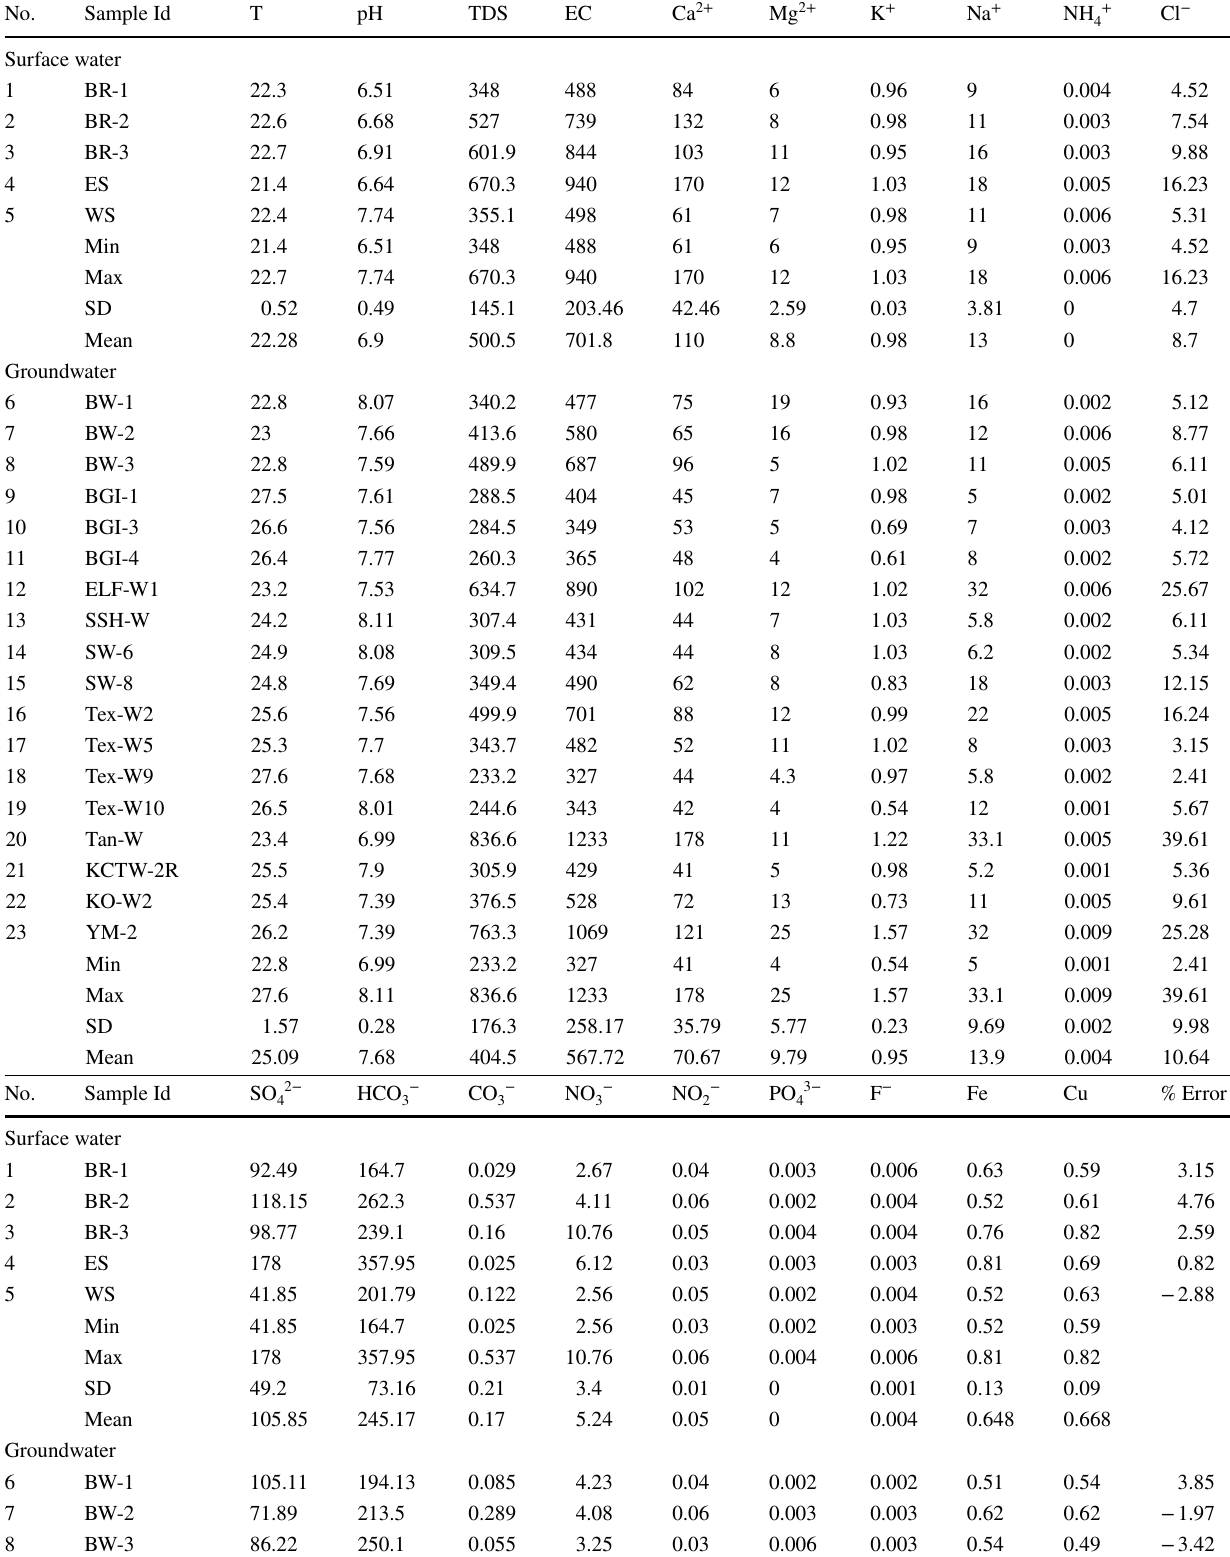
Table 4 Results of chemical analyses of the surface water and groundwater samples of the study area (date of sampling: Nov 2017); explanation: EC (µS/cm), concentrations (mg/l), temperature (°C)